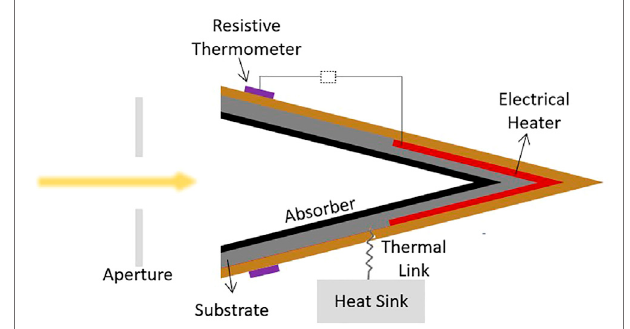
FIGURE 6 | Diagram of electrical substitution